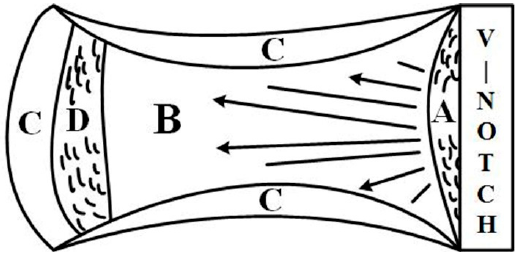
Figure 13. The screen zones of fracture surface after impact tests: fibrous zone (A), radial zone (B), shear lip zone (C) and second fibrous zone (D).